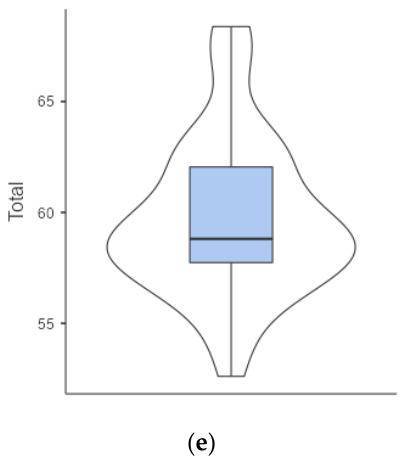
Figure A9. Boxplot and violin histogram of sperm length measures. ( a ) Acrosome; ( b ) head where two lengths are appearing, corresponding to what can be observed in the ejaculates; ( c ) midpiece, ( d ) tail and ( e ) total sperm length. Table A1. Arabian bustard overall yearly information on semen collection from 2018 to 2021. Only ejaculates that were not contaminated with urates, feces, or red blood cells were considered for overall semen characteristics.